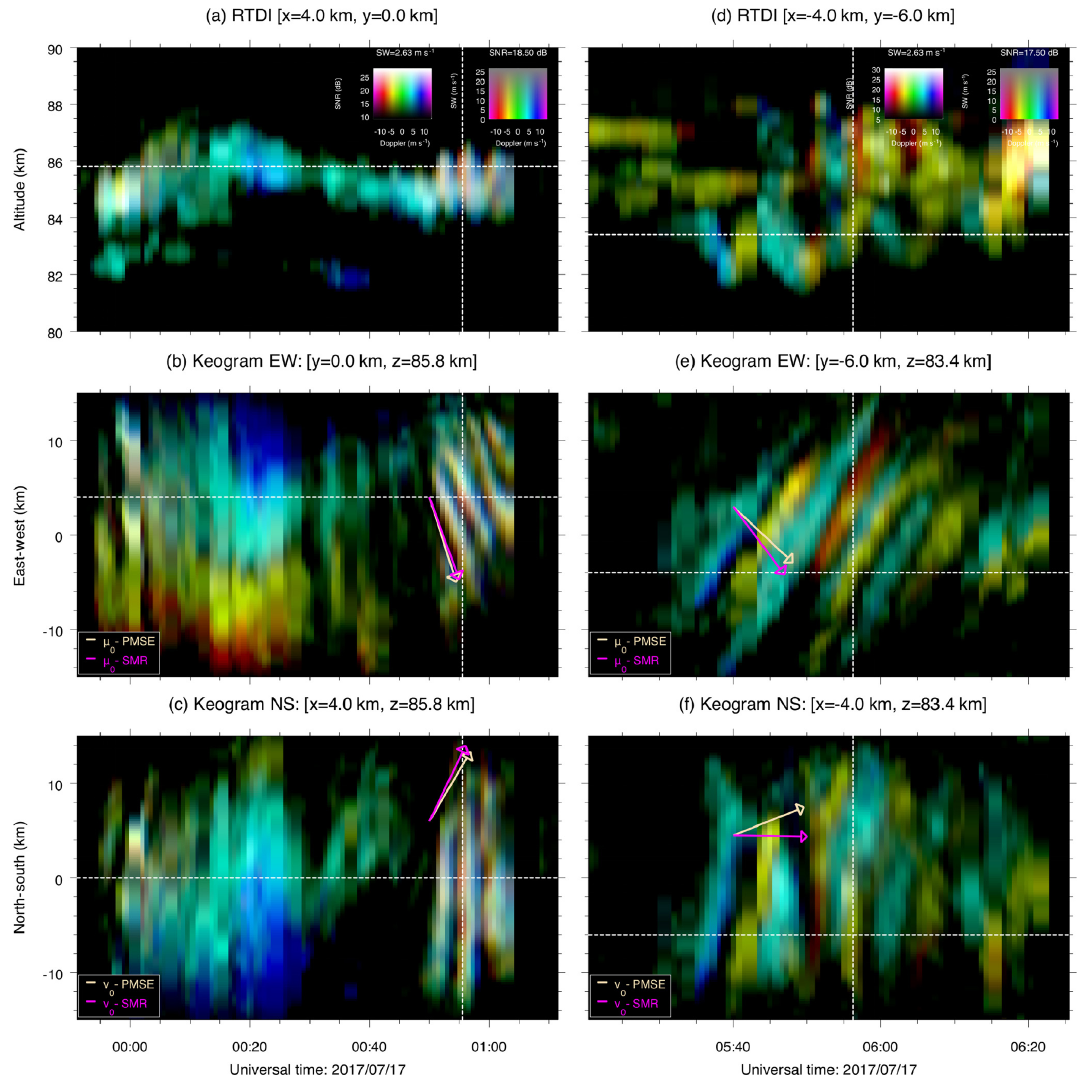
Figure 7. 24-bit time representation images of PMSE structures as a function of altitude (RTDI) (a, d) , EW location (keogram) (b, e) , and NS location (keogram) (c, f) for selected cuts, for both Event 1 (a, b, c) and Event 2 (d, e, f) . In the keograms, the wind components obtained with specular meteor radars (SMRs) and MAARSY PMSEs are shown by pink and yellow arrows, respectively. The white dashed horizontal lines represent the location of the altitude, EW and NS cuts shown in previous figures, and current keograms for Events 1 and 2. The white dashed vertical lines represent the time of the cuts shown in previous